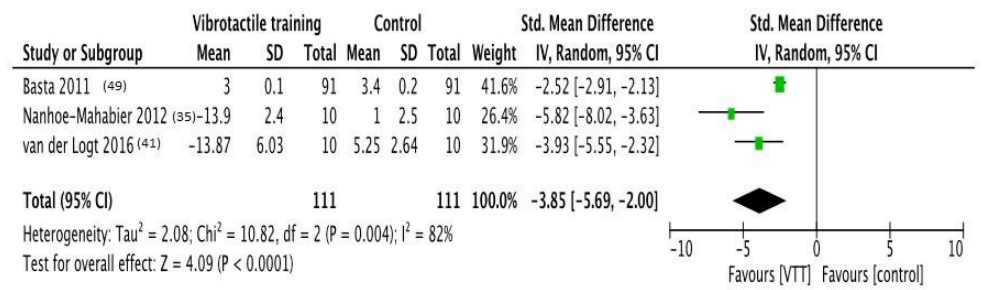
Figure 2. Forest plot of comparison: Overall effect of Vibrotactile feedback training in comparison to no-feedback interventions. Outcome: pitch sway angular velocity. Abbreviations: VTT, vibrotactile training; CI, confidence interval; SD, standard deviation [35,41,49].